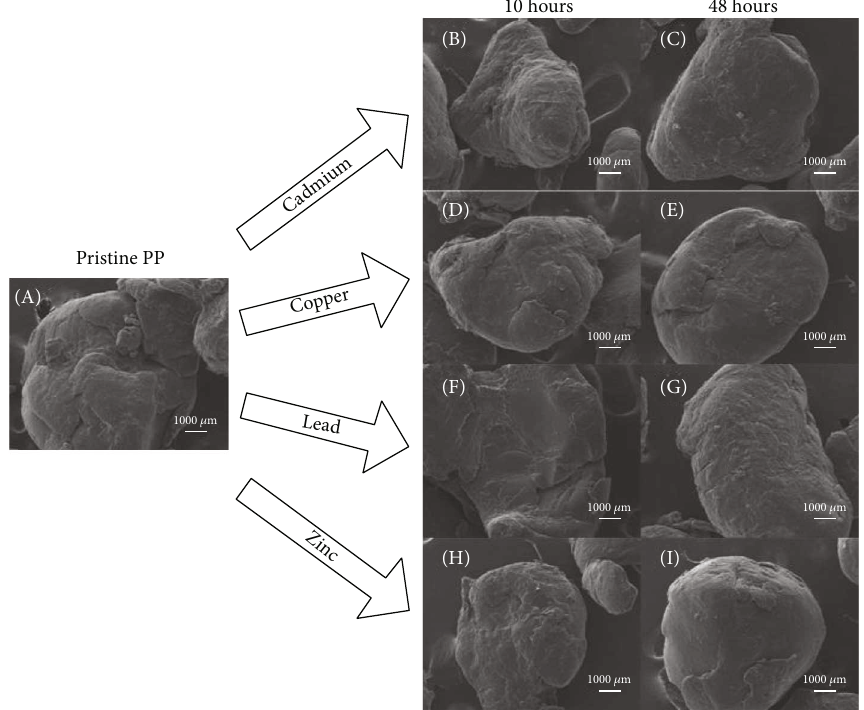
: 7 mg · L -1 , V = 20 mL, temperature at e = 0